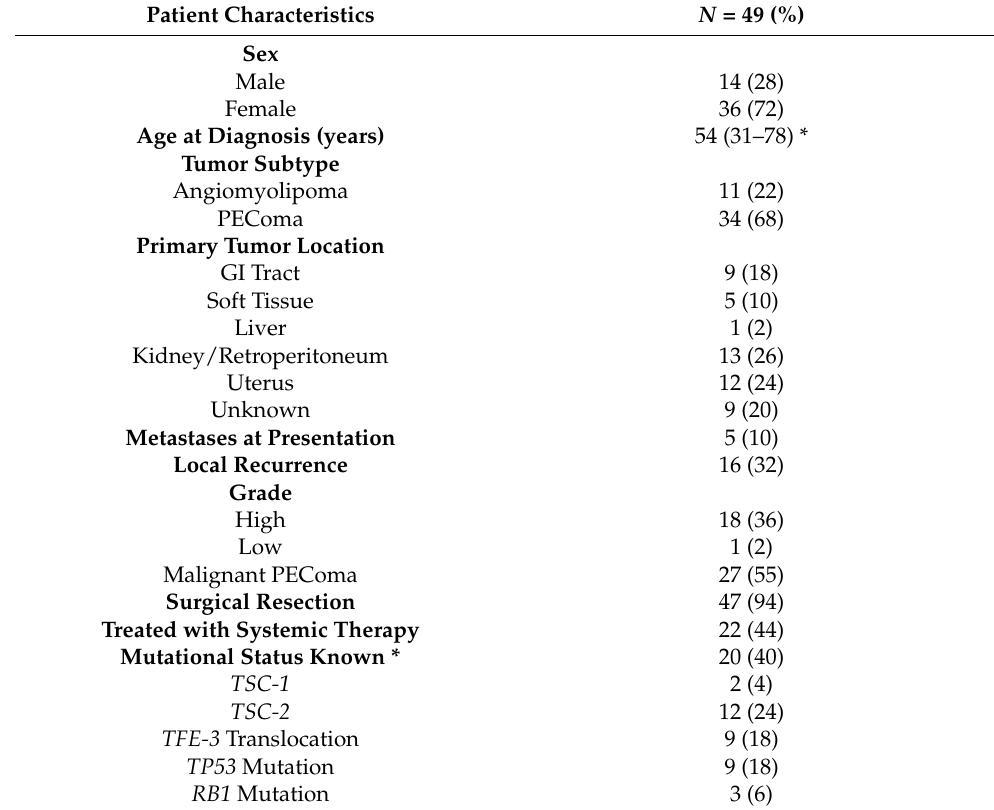
Table 1. Baseline characteristics. * Some cases had multiple mutations.